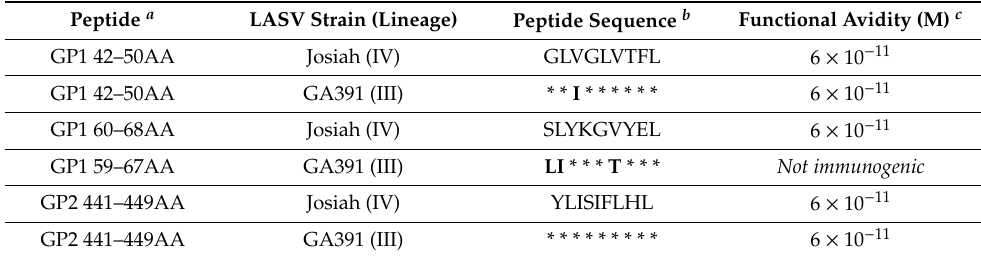
Table 2. LASV CD8 + T-cell epitopes and inter-lineage cross-reactivity. Peptide a LASV Strain (Lineage) Peptide Sequence